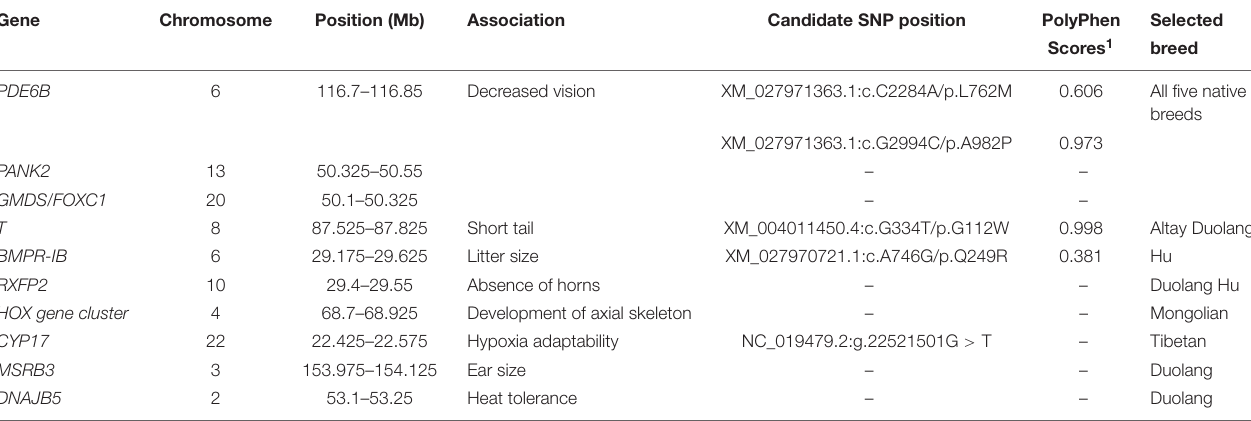
TABLE 1 | Summary of major candidate regions identified from the 150-kb windowed heterozygosity ( H P ) and fixation index ( F ST ) values for each breed comparison (see Supplementary Tables S9 – S27 for summary values of all candidate genes).